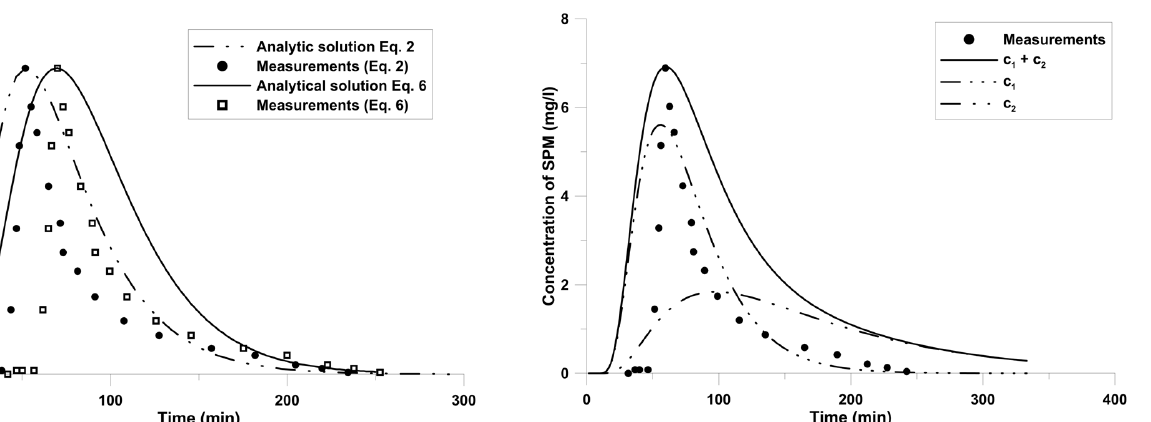
C:\Documents and Settings\brigitte.wilhelm\Desktop\Subversion\Journals\hess\hess-2011-329\author\hess-2011-329-manuscript- version4.doc